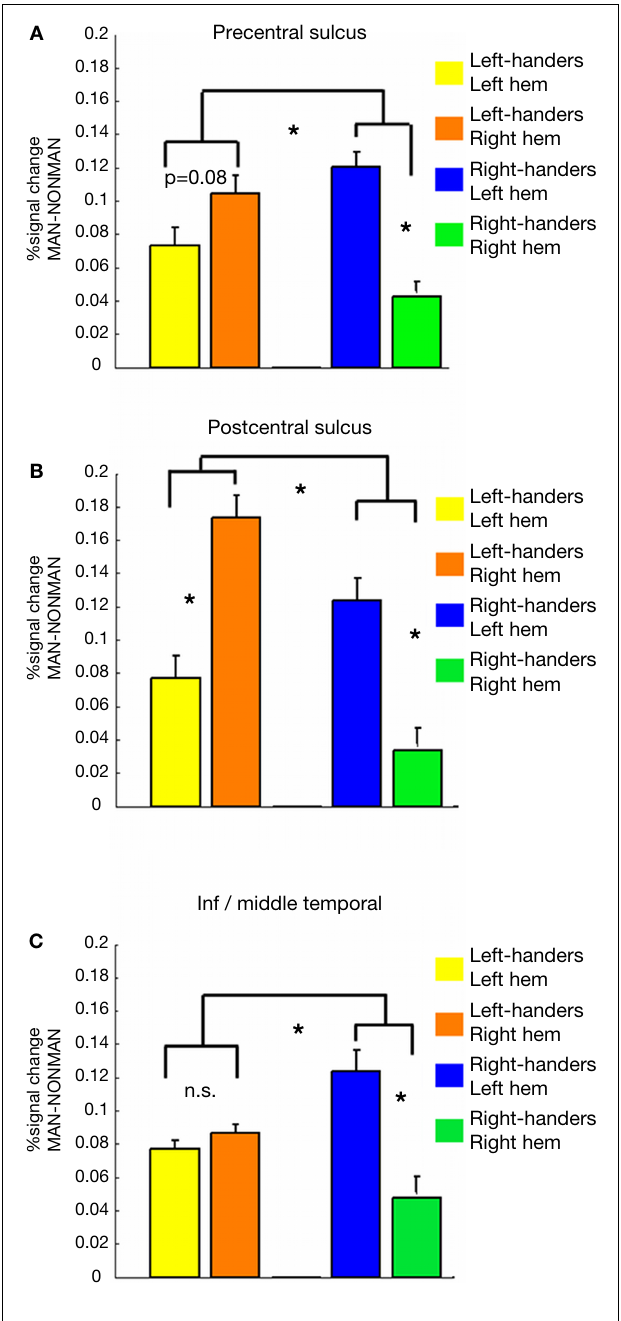
FIGURE 3 | Results in bilateral pairs of regions activated in the whole brain analysis to the overall MAN > NONMAN comparison (Figure 1). Displayed are the contrast values for the MAN > NONMAN contrast for: Left-handers , Left-handers , Right-handers , Right-handers . left hem right hem left hem right hem In all regions there is a HEMISPHERE × GROUP interaction ( Table 4 ). (A,B) In the precentral and postcentral sulcus, each group activated the hemisphere contralateral to their dominant hand more strongly than the other hemisphere. That is, right-handers activate these regions most strongly in the left-hemisphere, whereas left-handers activate them more strongly in the right-hemisphere. (C) For inferior/middle temporal cortex this within group difference was only present for right-handers (see text and Table 4 ). Asterisks indicate statistical signifi cance at the p < 0.05